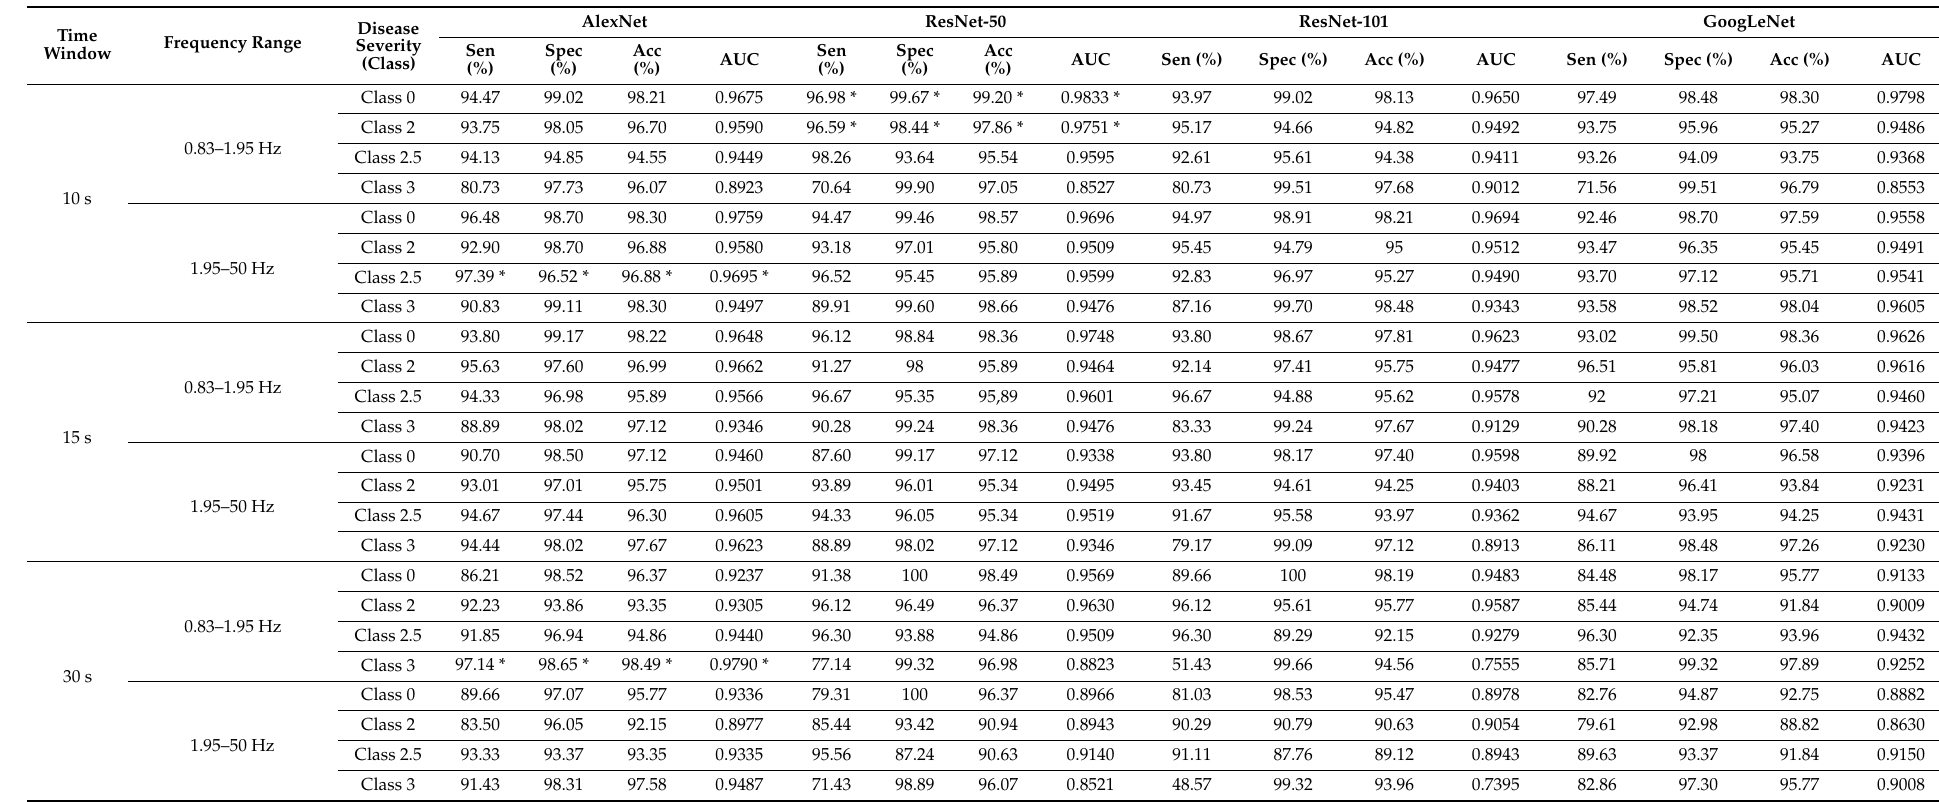
Table 6. Multi-class classification of LF from Ju dataset for CO (Class 0), PD Stage 2 (Class 2), PD Stage 2.5 (Class 2.5), and PD Stage 3 (Class 3) using several CNN classifiers (AlexNet, ResNet-50, ResNet-101, and GoogLeNet) with 10-fold